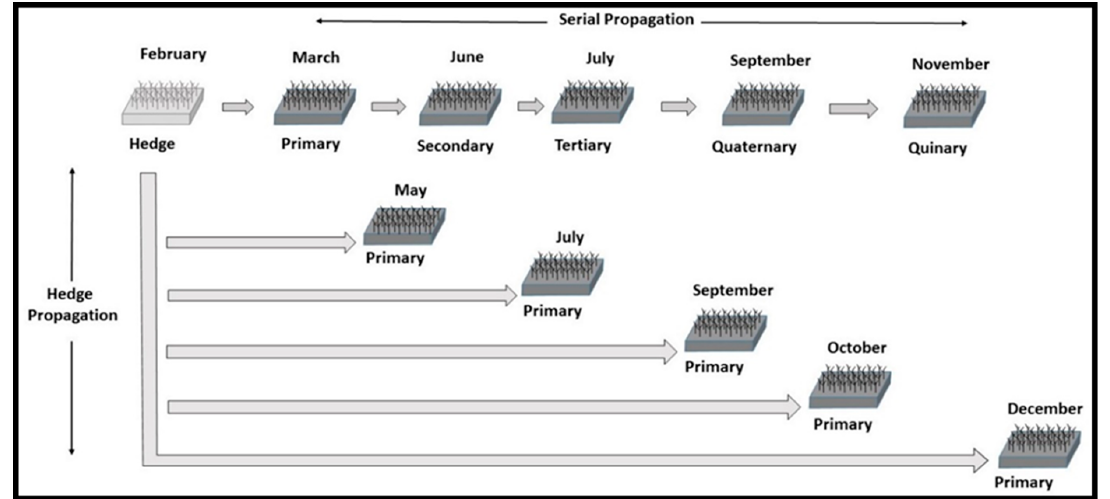
Figure 1. Schematic showing five cycles of greenhouse hedge and serial propagation.